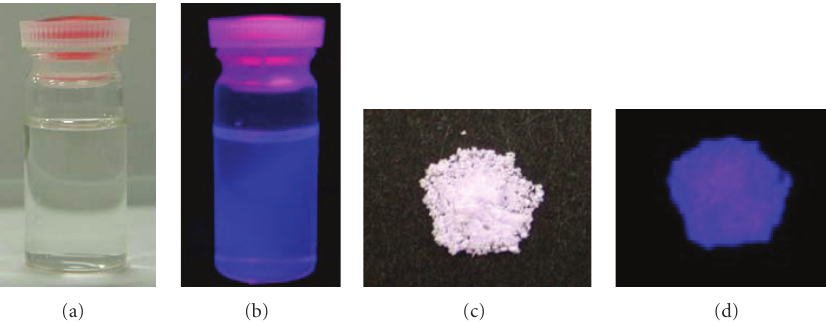
Figure 1: Appearance of silica particles incorporating ZnSe-based NCs prepared using Solution 2: (a) cyclohexane solution under visi- ble light, (b) cyclohexane solution under UV light (wavelength: 365 nm), (c) powder under visible light, and (d) powder under UV light (wavelength: 365